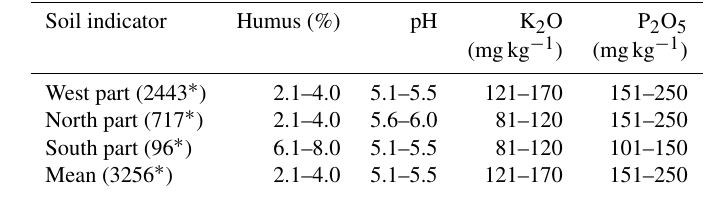
Table 1. Average values of soil indicators for different parts of the Republic of Tatarstan.